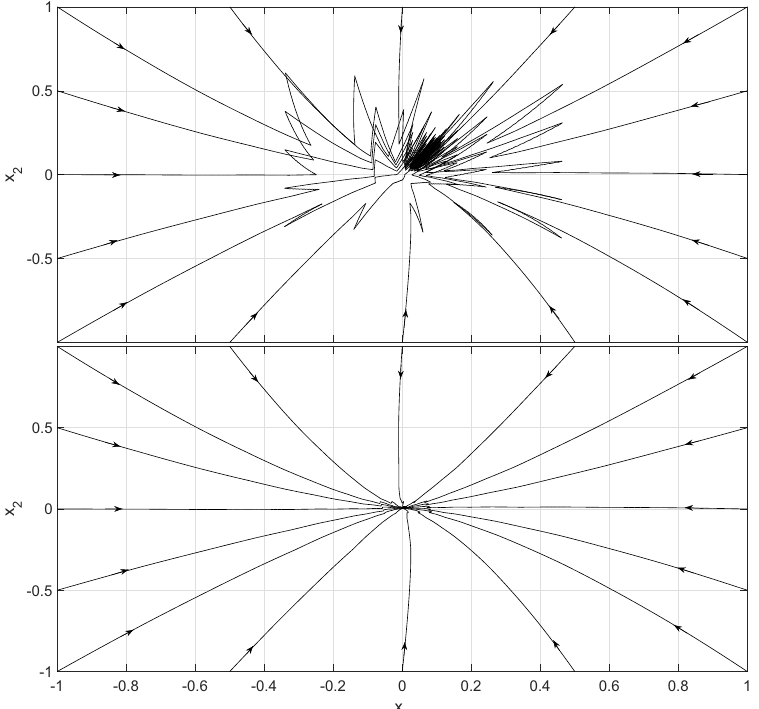
Figure 7. Phase portrait comparing [15] (upper plot) and the approach of this paper (lower